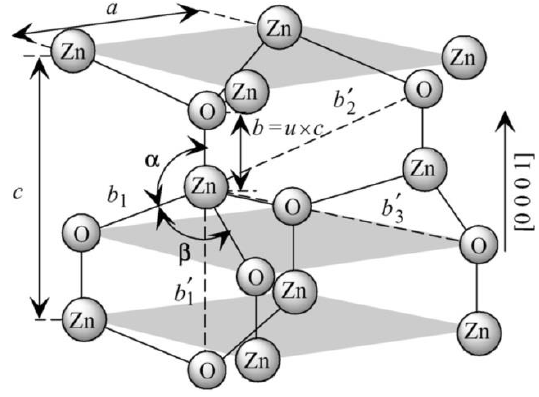
Figure 2. Schematic representation of a wurtzitic ZnO structure with lattice constants a in the basal plane and c in the basal direction, u parameter, which is expressed as the bond length or the nearest-neighbour distance b divided by c (0.375 in an ideal crystal), a and b (109.47 in an ideal crystal) bond angles, and three types of second-nearest-neighbour distances b ´ 1 , b ´ 2 , and b ´ 3 . Reprinted from [97], with the permission of John Wiley & Sons, Inc. Copyright 2009. All rights reserved. In order to re-use permission must be obtained from the rightsholder. Table 1. Physical properties of ZnO with the wurtzite structure. Data were derived from literature [98–107].